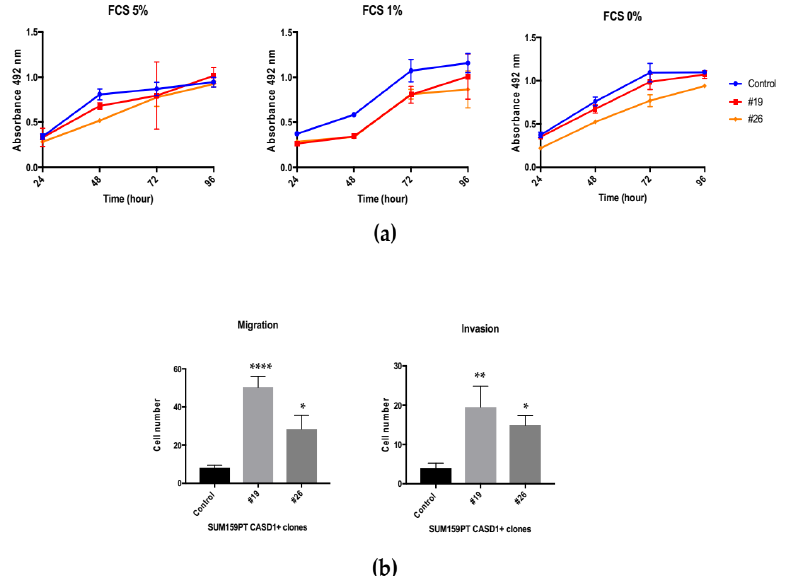
Figure 8. Biological properties of SUM159PT CASD1+ clones. ( a ) The growth of control and SUM159PT CASD1+ #19 and #26 clones was assessed after 0 h, 24 h, 48 h, 72 h, and 96 h us- ing MTS reagent (Promega, Madison, WI, USA) in media containing 5%, 1% or 0% of fetal calf serum (FCS). ( b ) The migration and invasion capabilities of control and SUM159PT CASD1+ clones #19 and #26 were assessed after 48 h by Transwell assay in serum free media. Statistical difference using